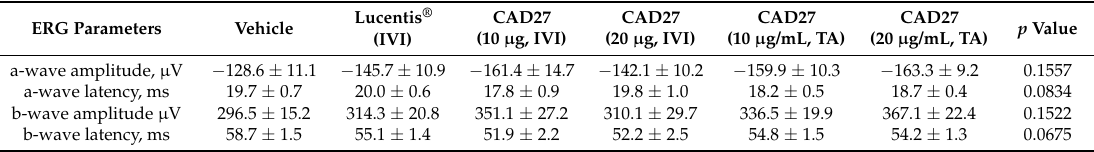
Table 1. The effect of intravitreal and topical application of CAD27 on retinal function assessed by electroretinography (ERG).